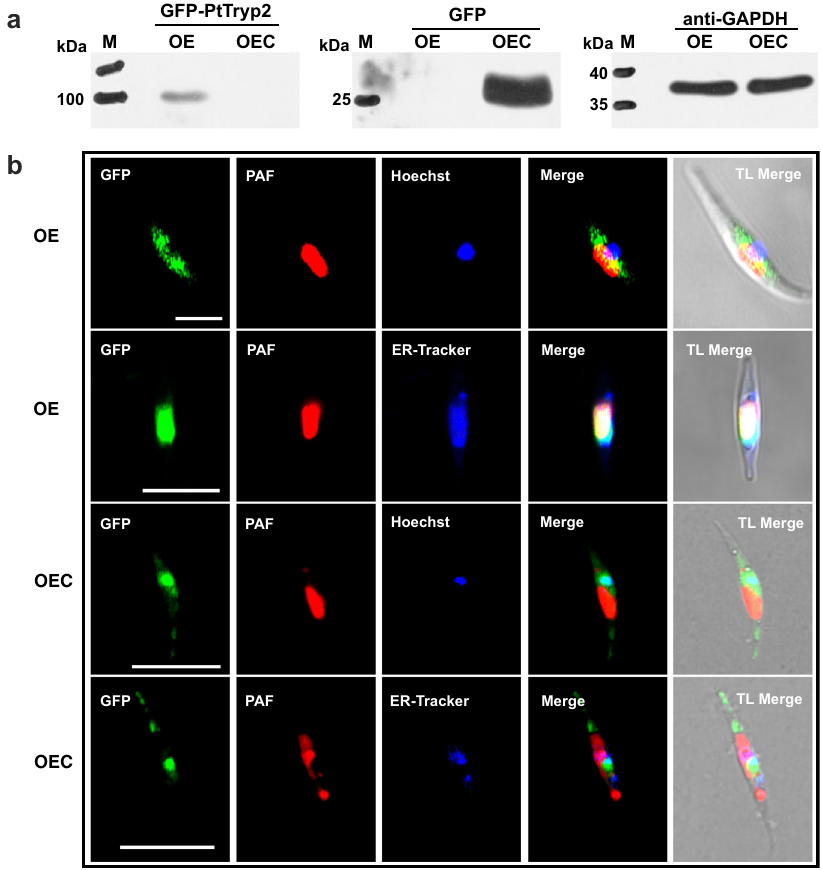
Fig. 3 Subcellular localization of PtTryp2. a Detection of the expression of GFP- PtTryp2 by Western blot using anti-GFP primary antibody. Left panel, GFP- PtTryp2 fusion protein. Middle panel, GFP protein. GAPDH (on the right) was detected using anti-GAPDH as the control to indicate equal protein quantities loaded to each lane. The GFP- PtTryp2 was con fi rmed expressed successfully at protein level in OE cell line. All experiments were repeated independently three times, and similar results were obtained. b Confocal micrographs showing subcellular localization of GFP- PtTryp2 in chloroplast (PAF, showing red auto fl uorescence) and endoplasmic reticulum (ER, showing blue fl uorescent stain by ER-Tracker) but not in nucleus (Hoechst 33342, showing blue fl uorescent stain). TL merge, merger of the fl uorescence images with transmission light image. Scale bar, 10 µ m, applies to all images. All experiments were repeated independently three times, and similar results were obtained. Source data are provided as a Source Data fi